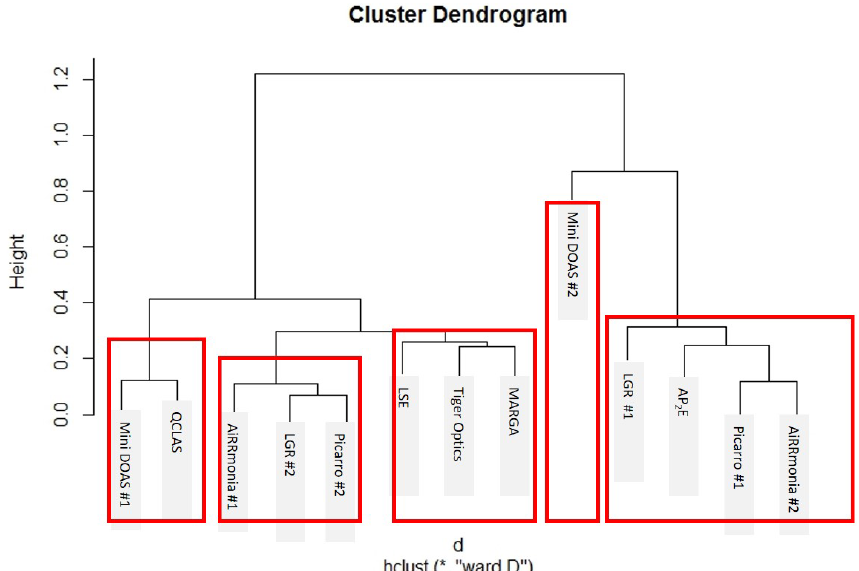
Figure 12. Euclidean distances between instruments based on their coefficients of divergence for the period of 23 August 2016, 00:00, to 29 August 2016, 01:00, based on their hourly averages. Height relates to the order at which the clusters occurred. The red boxes indicate the instruments that are clustered together.